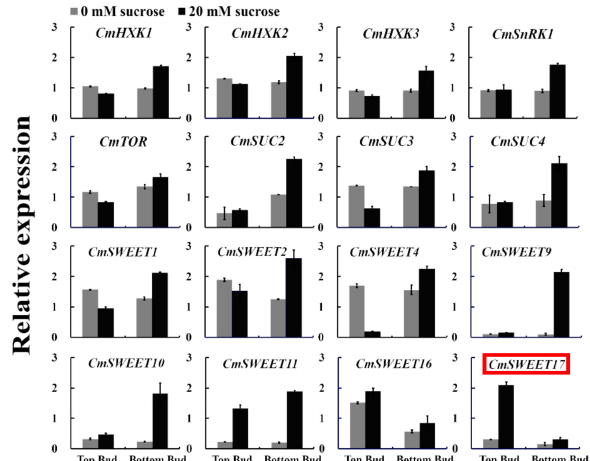
Figure 1. Relative expression of sugar-related genes in the axillary bud following the two-node stems